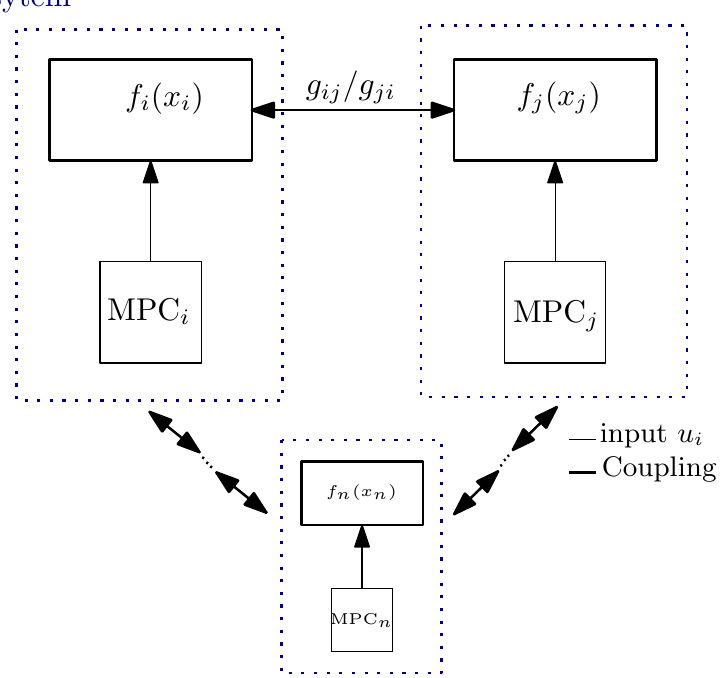
Figure 1. Control schematic for interconnected